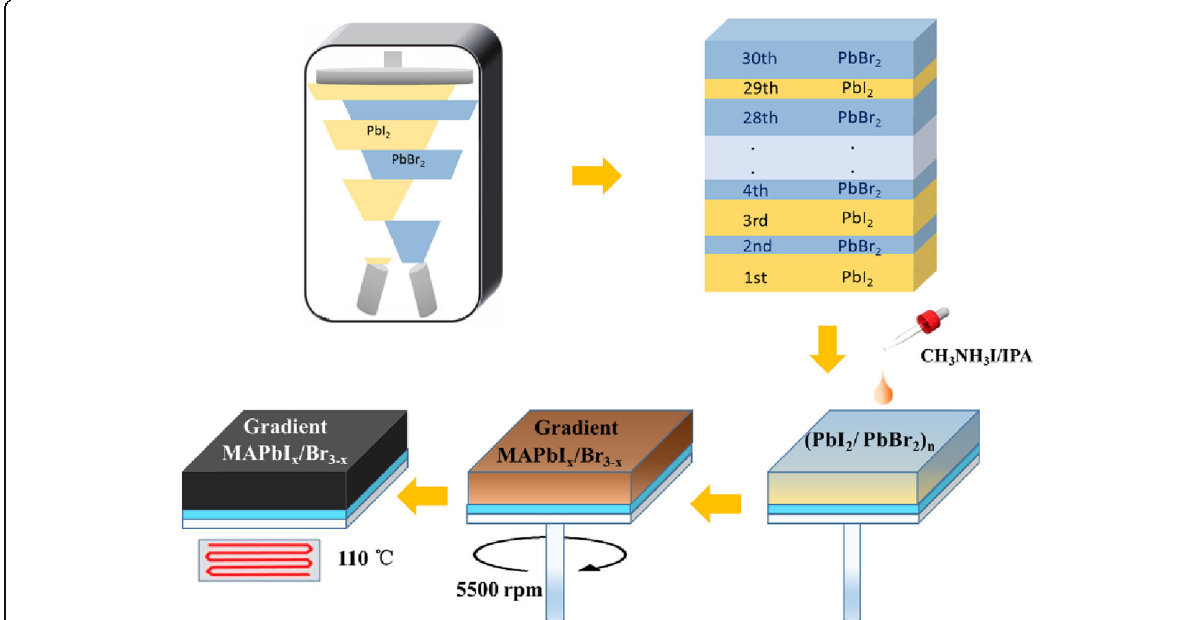
Fig. 1 Schematics of the fabrication process of gradient MAPbI x Br 3 − x perovskite films